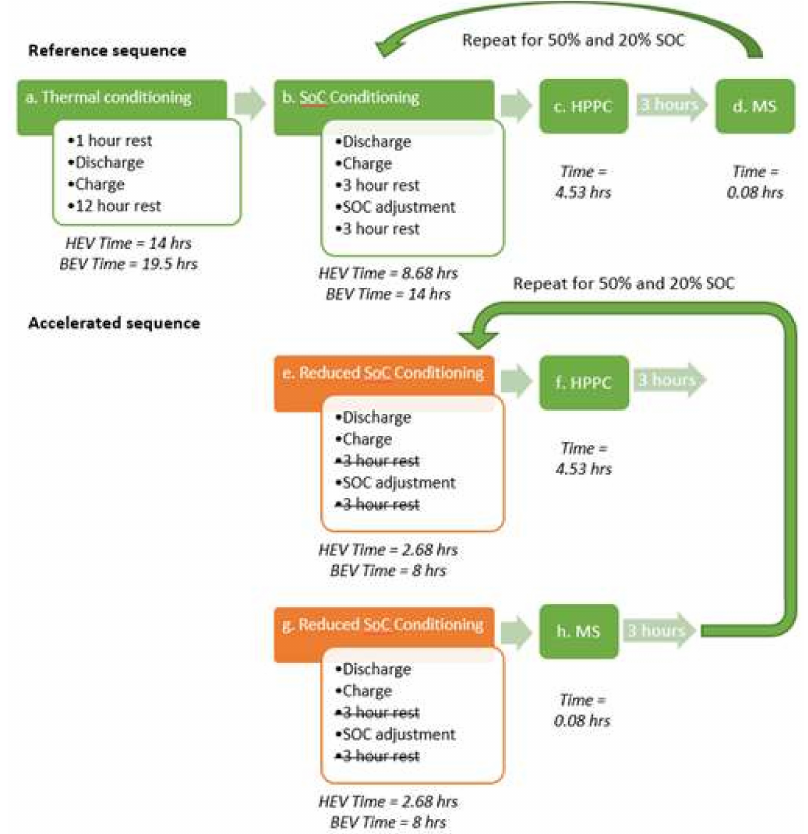
Figure 3. Internal resistance measurements of the reference and accelerated test sequences at 25 ◦